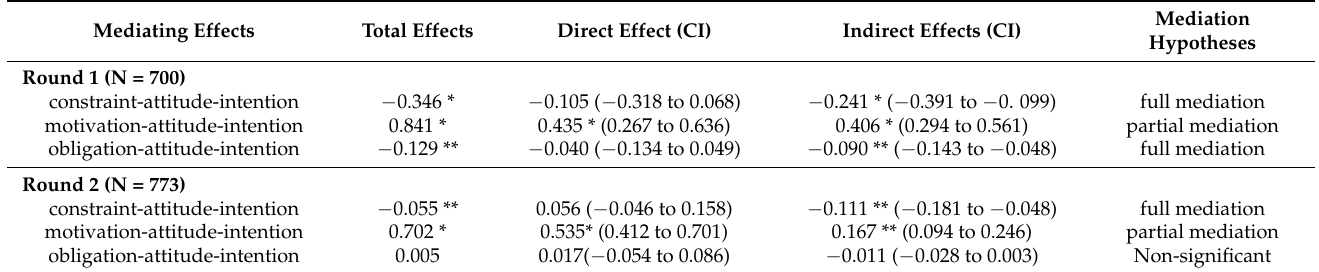
Table 5. Bootstrapping methodology for mediating